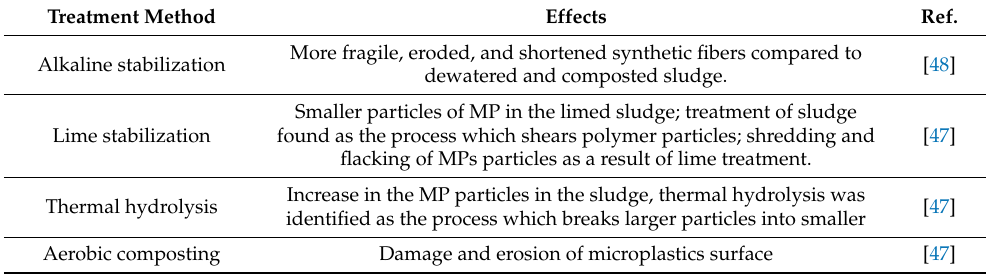
Table 5. The effect of the sludge treatment method on the characteristics of microplastics in the